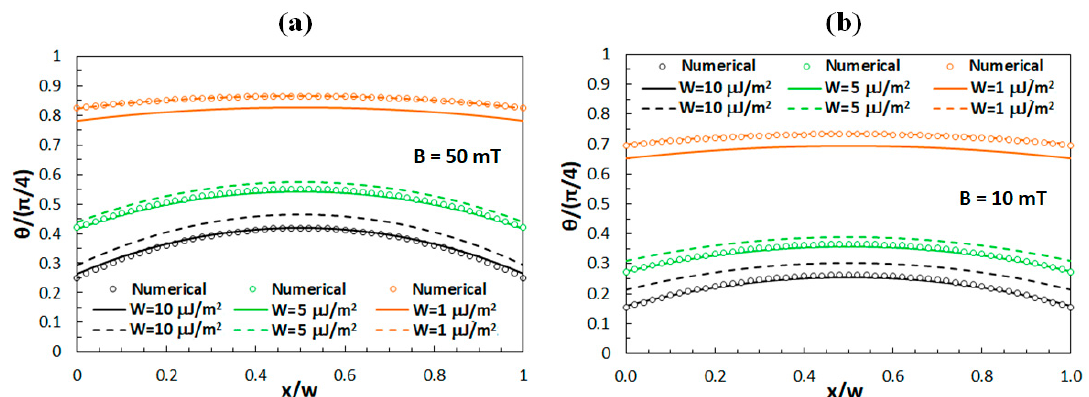
Figure 2. Numerical and analytical results for θ ( x ) for external magnetic fields of ( a ) 50 mT and ( b ) 10 mT. Circles correspond to the numerical solution, solid lines to Equation (9), and dashed lines to Equation (10). The results are given for three different values of the anchoring strength W .